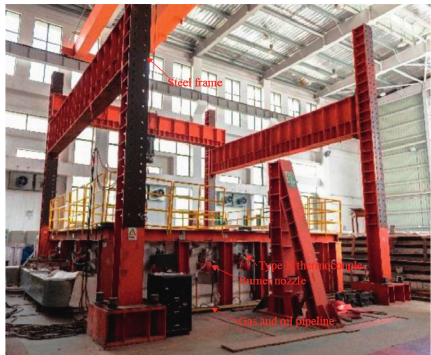
Figure 3: View of the furnace.